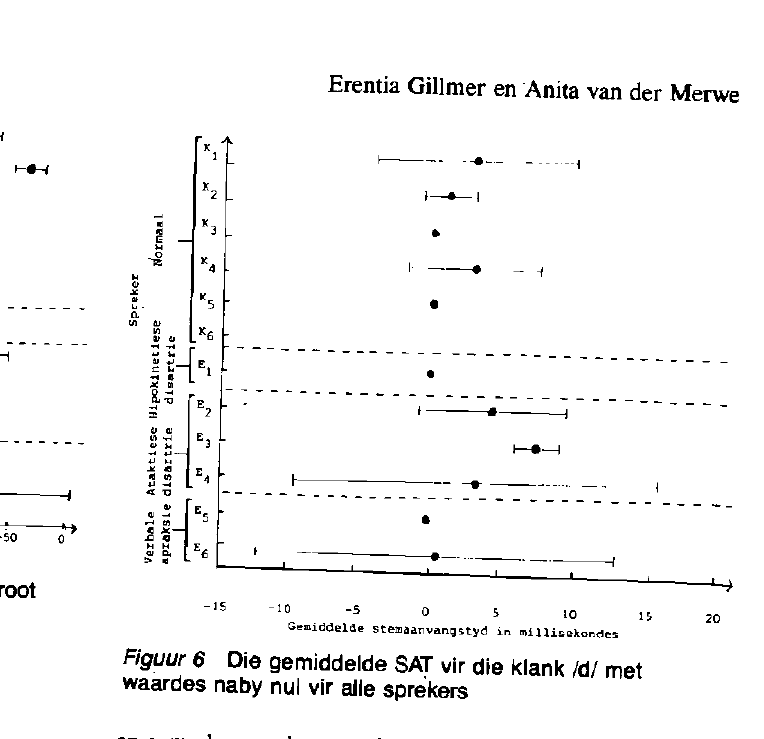
Figuur 6 Die gemiddelde SAT vir die klank /d/ met waardes naby nul vir alle sprekers en soms 'n waarde wat naby nul le. Die twee soorte waardes is gevolglik apart geneem en word apart in die grafieke